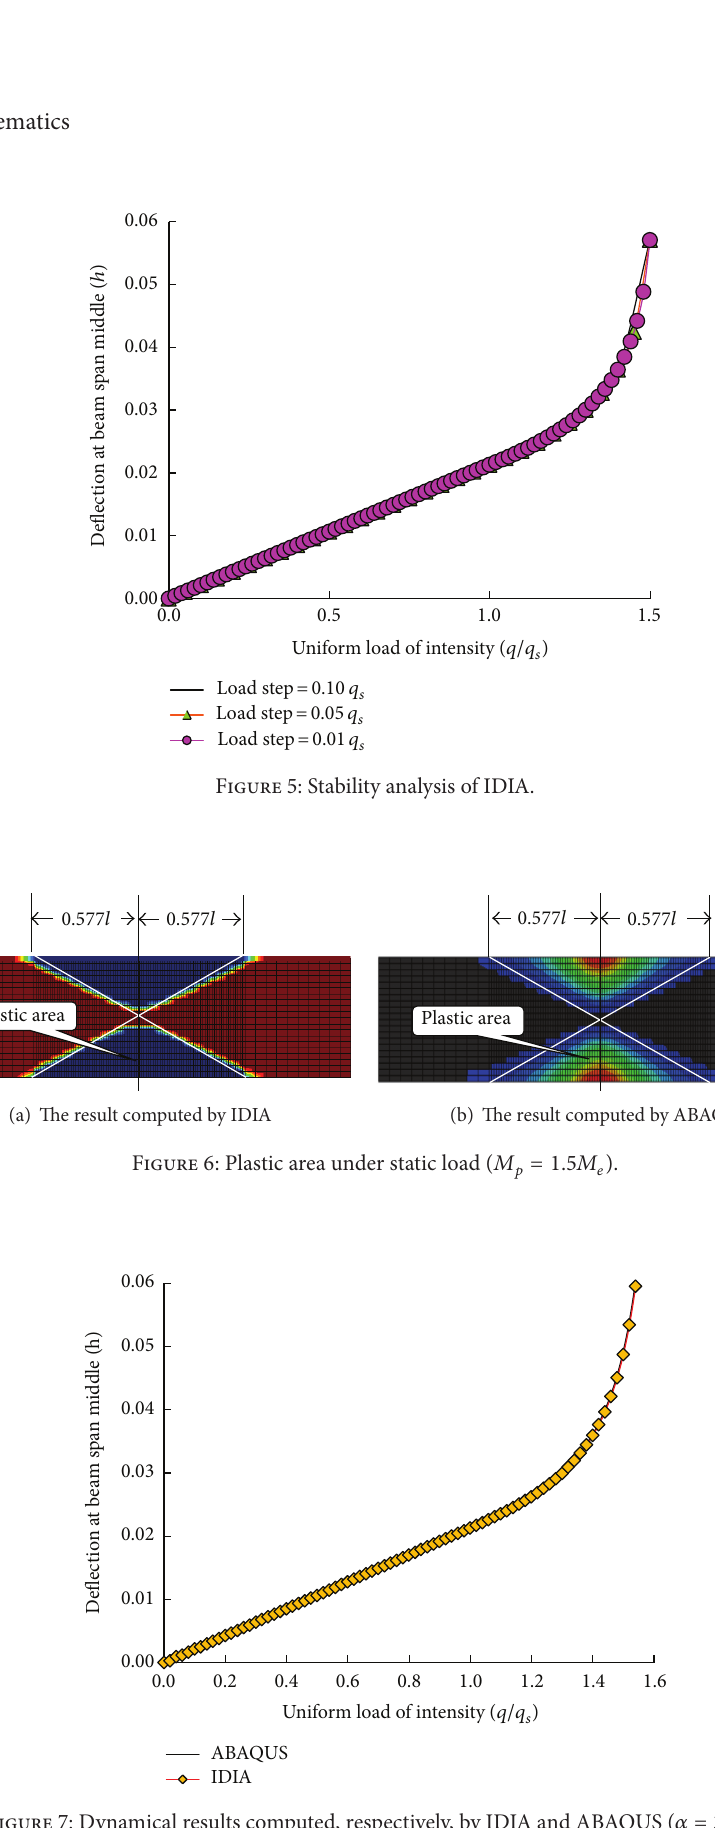
Figure 7: Dynamical results computed, respectively, by IDIA and ABAQUS ( 𝛼 = 30.0